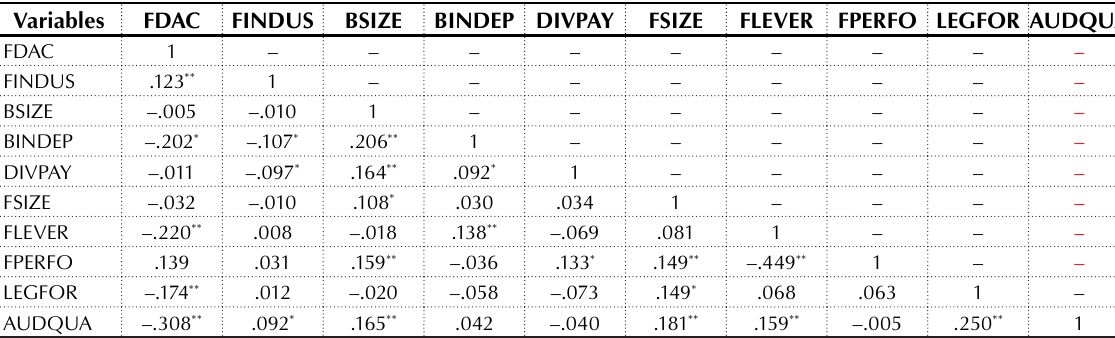
Table 4. Correlation between the EQ and other variables Variables